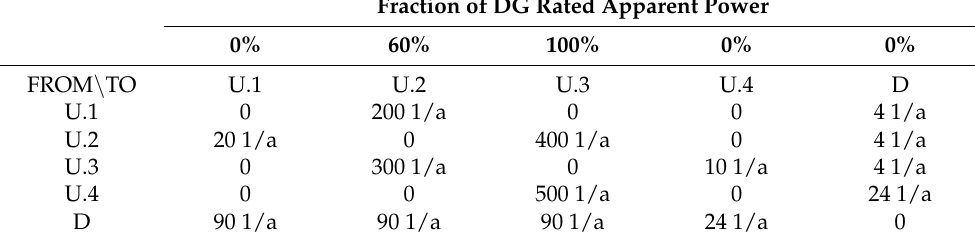
Table 4. Reliability parameters of WTPP